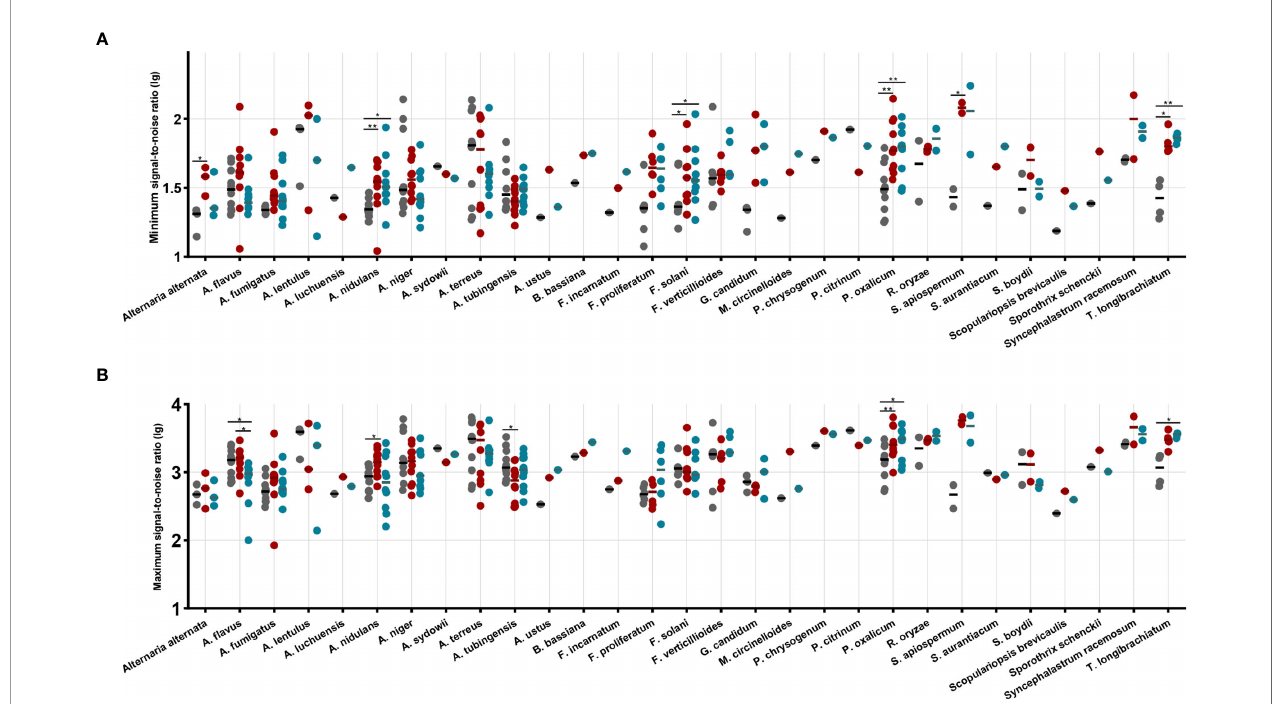
FIGURE 1 | The maximum signal-to-noise ratio (A) and the minimum signal-to-noise ratio (B) by species and by method performed. Each dot represents the signal- to-noise ratio (lg) for each isolate identi fi cation achieved by routine (black dots), ZSB (red dots), and FUS (blue dots) methods. Horizontal bars represent the mean ratio (lg) achieved by each method for each species including at least two isolates. A paired t-test was performed to analyze differences between each two groups, and statistical signi fi cance was de fi ned by p values less than 0.05 (* p < 0.05, ** p <